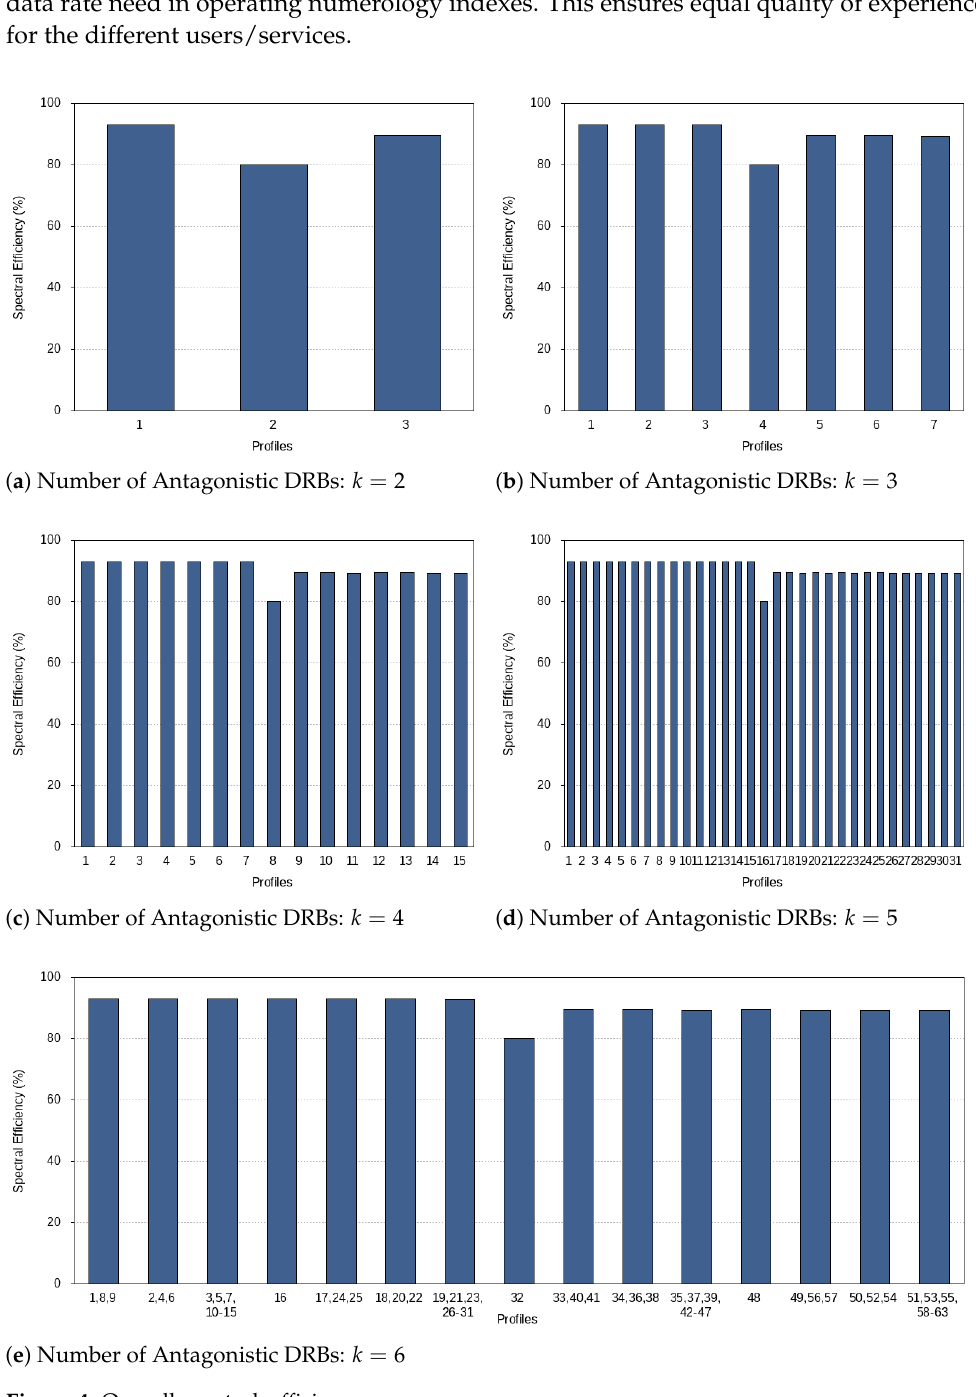
Figure 4. Overall spectral